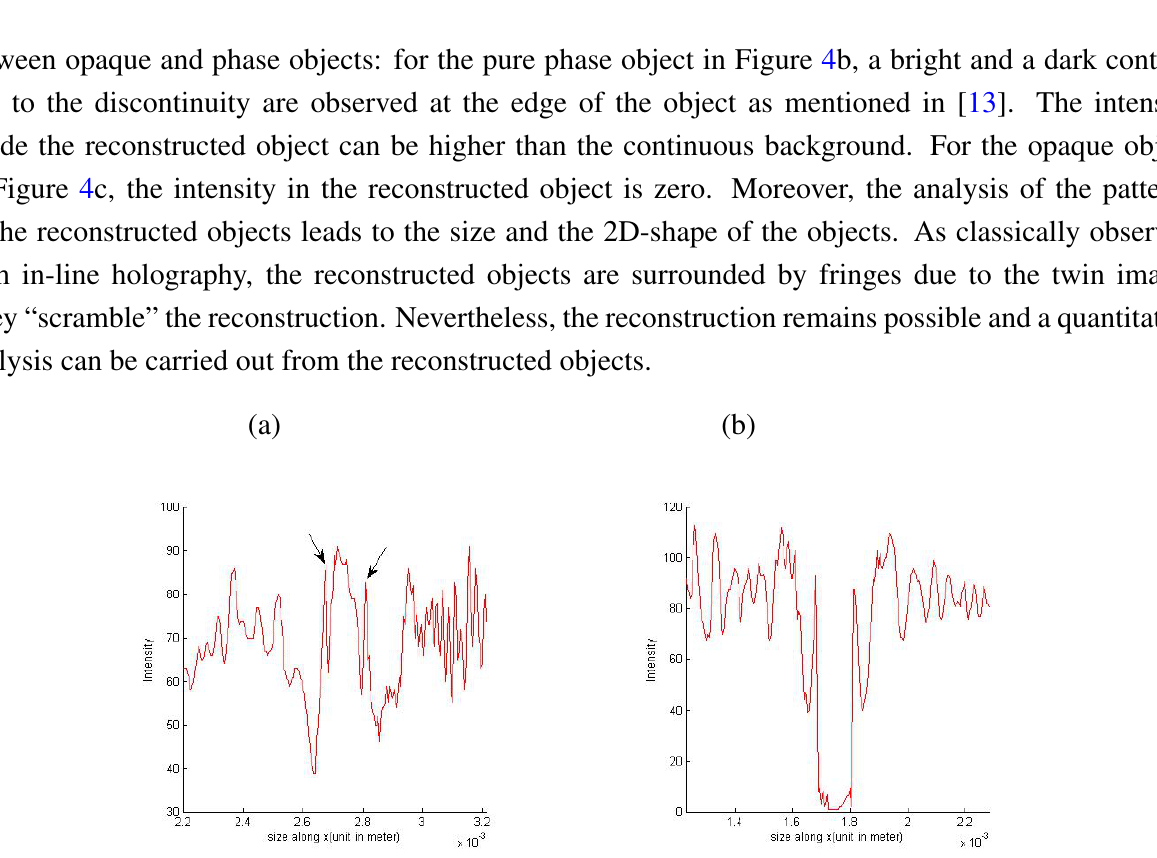
Figure 6: it is the abrupt transition between points A and B (points plotted in the case ϕ = π ). The amplitude of the discontinuity is directly linked to the phase shift introduced by the object. It has been shown that parameter y A − y B is a monotonic function versus ϕ for a circular object [13]. y y c